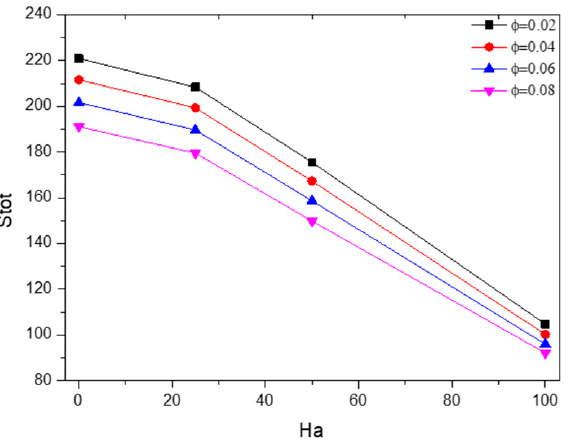
Figure 17. Average Nusselt number (Nu ave ) as a function of Hartmann number (Ha) at various values of φ . Ra = 10 6 , Da = 0.01, and ε p = 0.4.